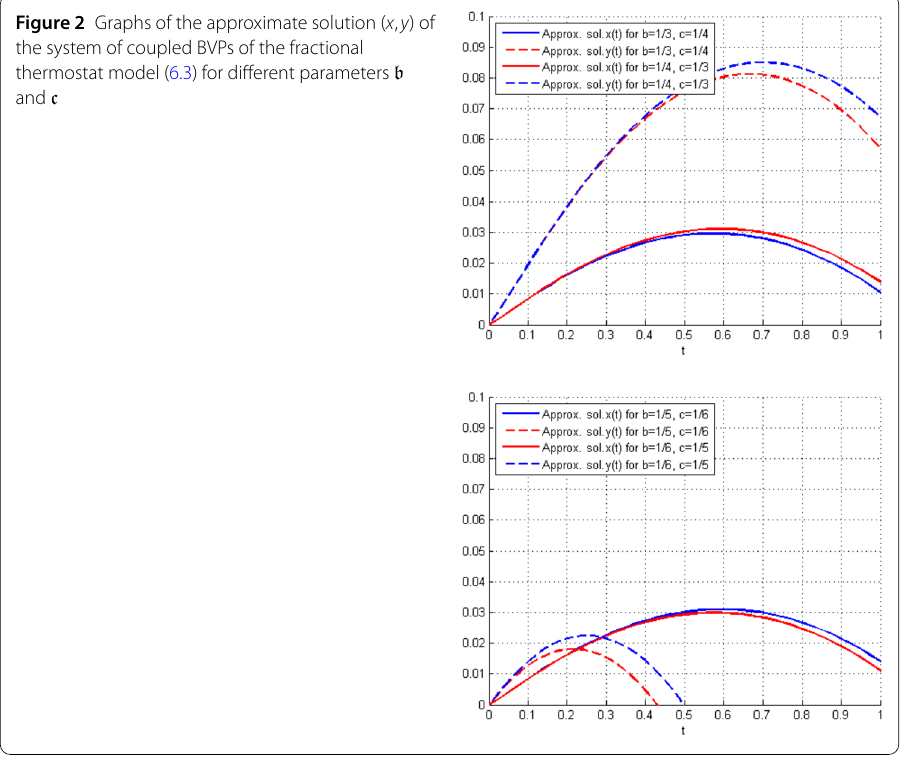
Figure 2 Graphs of the approximate solution ( x , y ) of the system of coupled BVPs of the fractional thermostat model (6.3) for different parameters b and